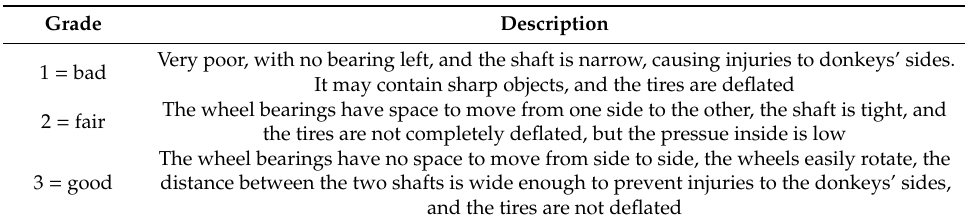
Table 3. Cart condition